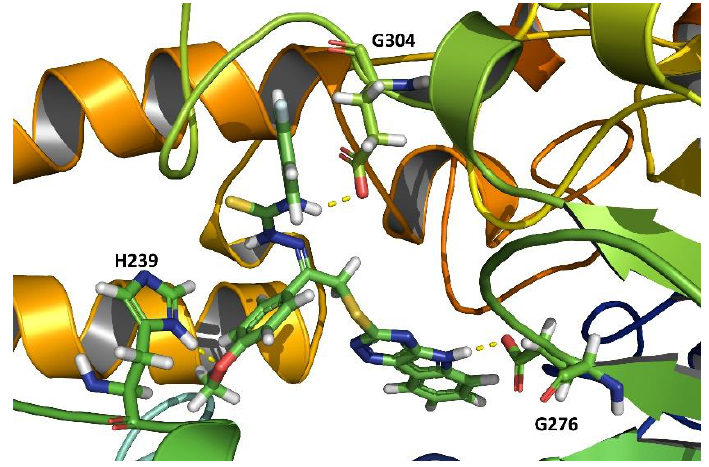
Figure 5. Docking position of compound 16 in the active site of the α-glucosidase enzyme .